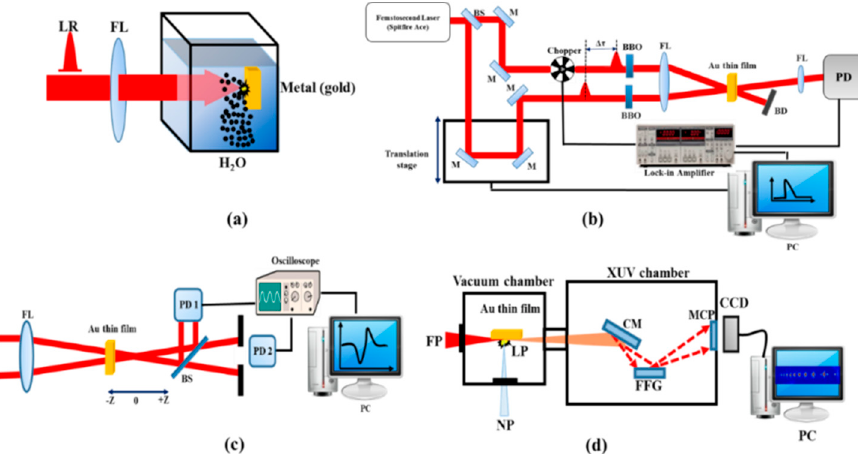
Figure 1. ( a ) Schematic of laser ablation. LR, laser radiation; FL, focal lens. ( b ) Schematic of the transient absorption measurements. BS, beam splitter; M, mirrors; FL, focal lenses; PD, photo diode; BD, beam dumper; BBO, barium borate crystal; PC, personal computer; ( c ) Schematic of Z-scan. FL, focusing lens; PD1, photodiode 1; PD2, photodiode 2. ( d ) High-order harmonic generation (HHG) setup. FP, converting femtosecond pulses; NP, heating nanosecond pulses; LP, laser plasma; CM, cylindrical gold-coated mirror; FFG, flat field grating; MCP, microchannel plate; CCD, charge-coupled device camera.